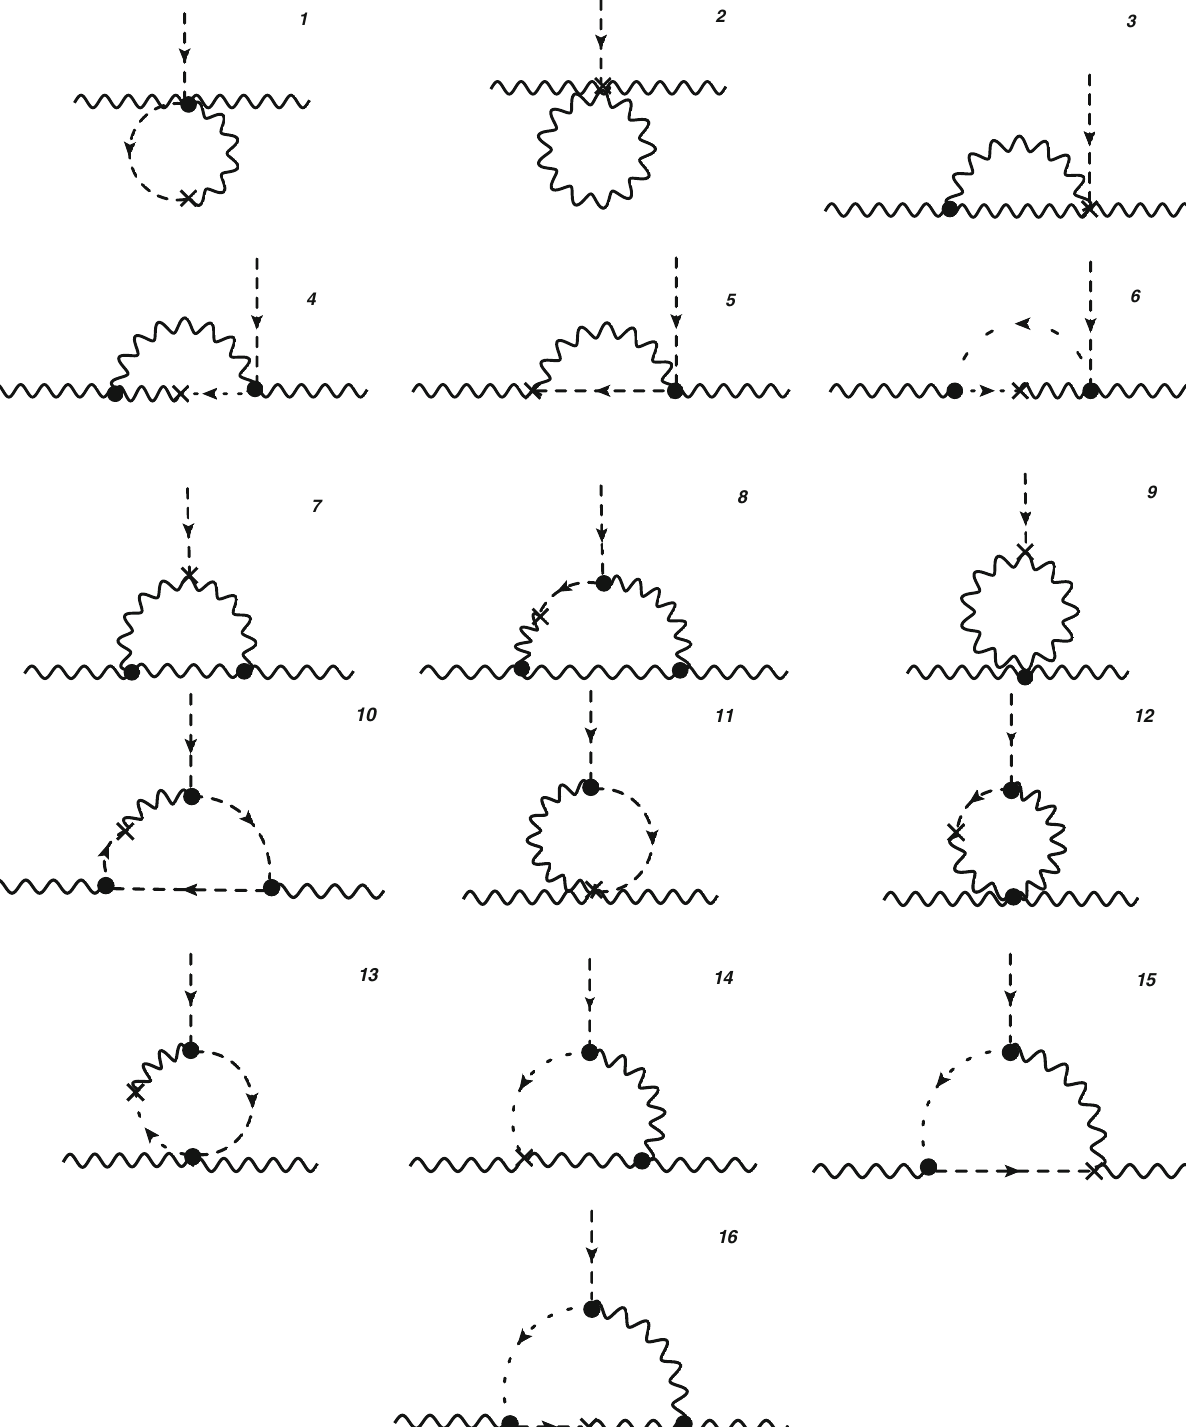
lattice regularization. A cross denotes the insertion of the operator. A mirror version (under exchange of the two external gluons) of diagrams 3, 4, 5, 6, 8, 10, 14, 15 and 16 must also be